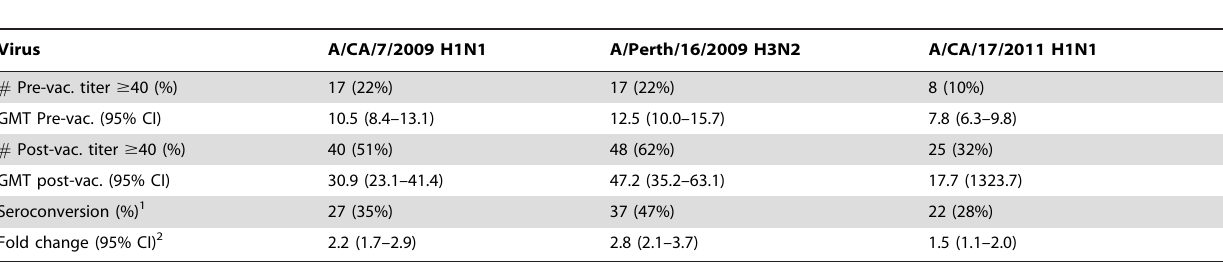
Table 1. Serologic responses in vaccinated recruits as measured by microneutralization assay, LAIV-vaccinated recruits (n= 78).